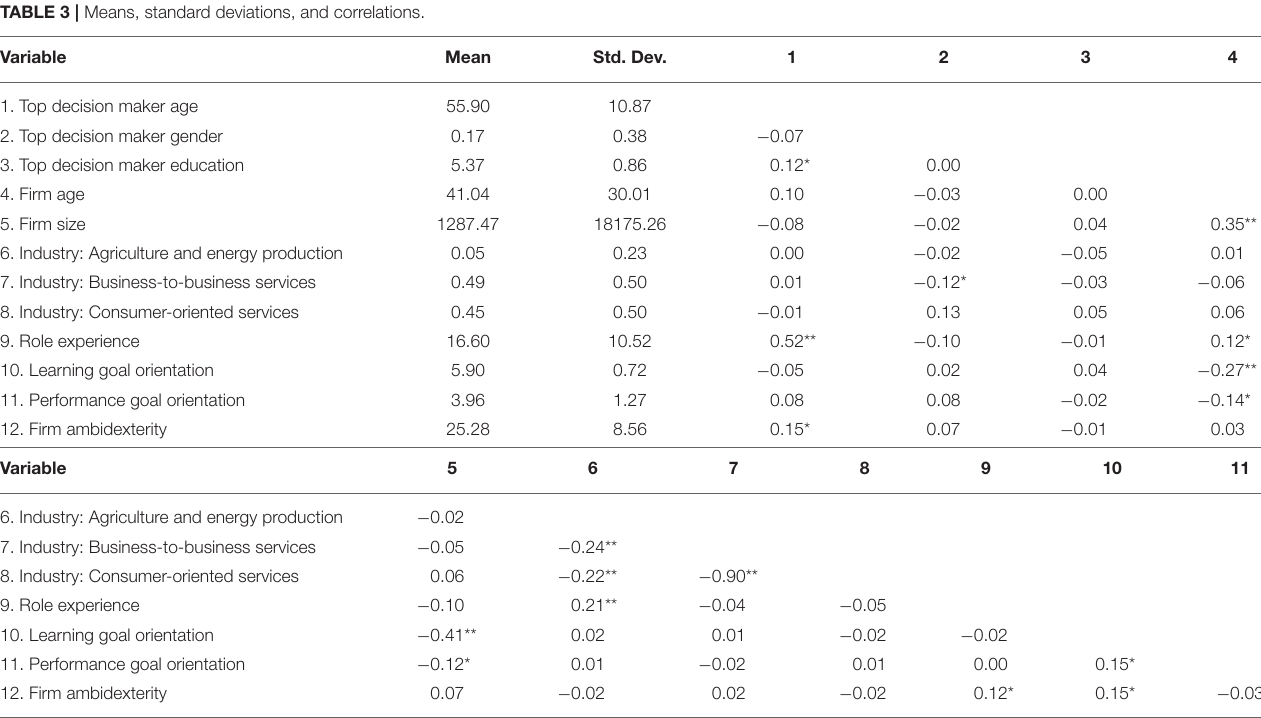
TABLE 3 | Means, standard deviations, and